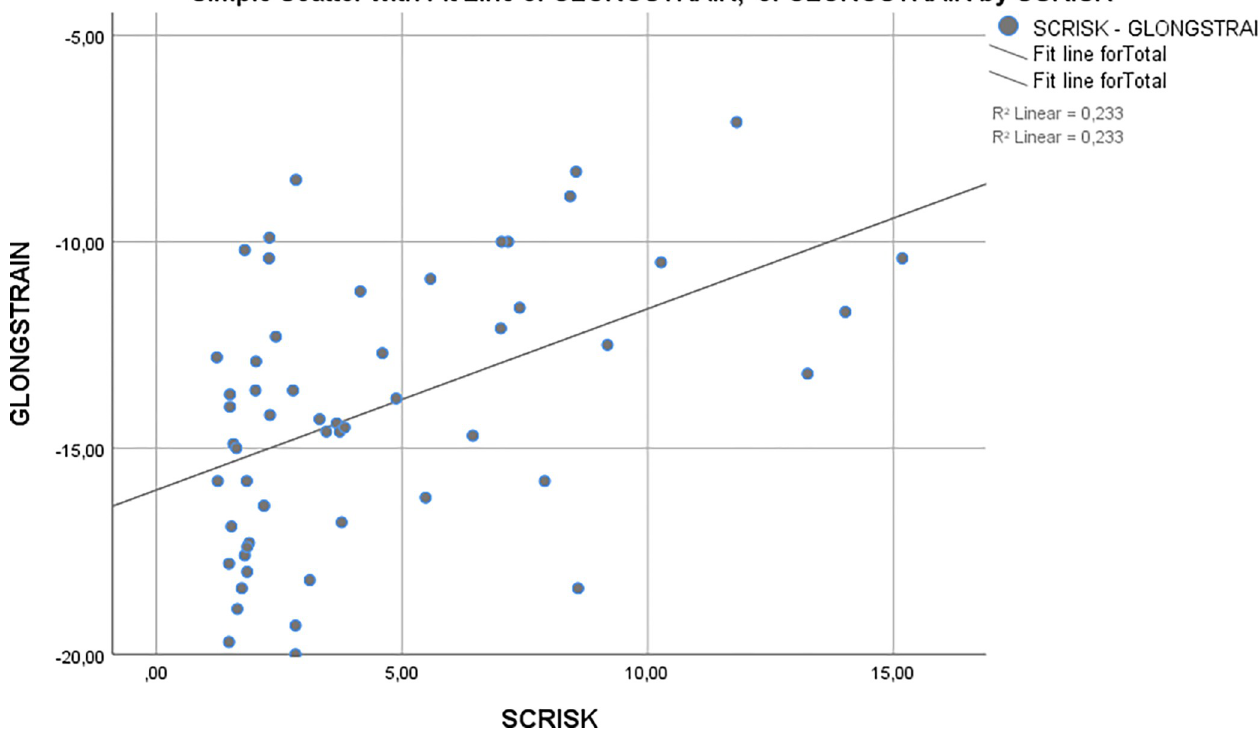
Fig 2. Correlation of global longitudinal strain with SCD risk